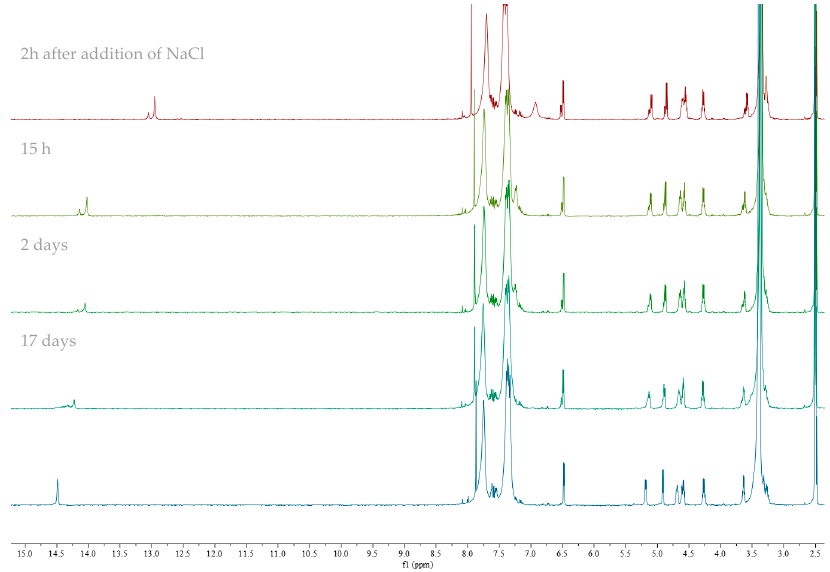
Figure 5. Evolution of the 1 H NMR spectrum of complex 5 in deuterated DMSO at room temperature during different times after addition of 10 equivalents of NaCl to a 33-day-old solution.